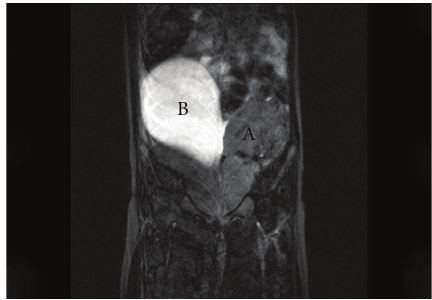
Figure 2: T2 coronal section of fat-suppressed abdominal magnetic resonance scan showing di ff erent signal intensities in solid compo- nent (A) and high signal in cystic component (B).